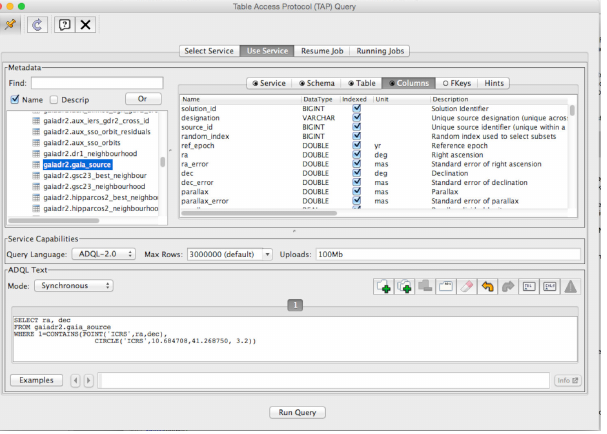
Fig. 58.— An ADQL query entered in the TAP